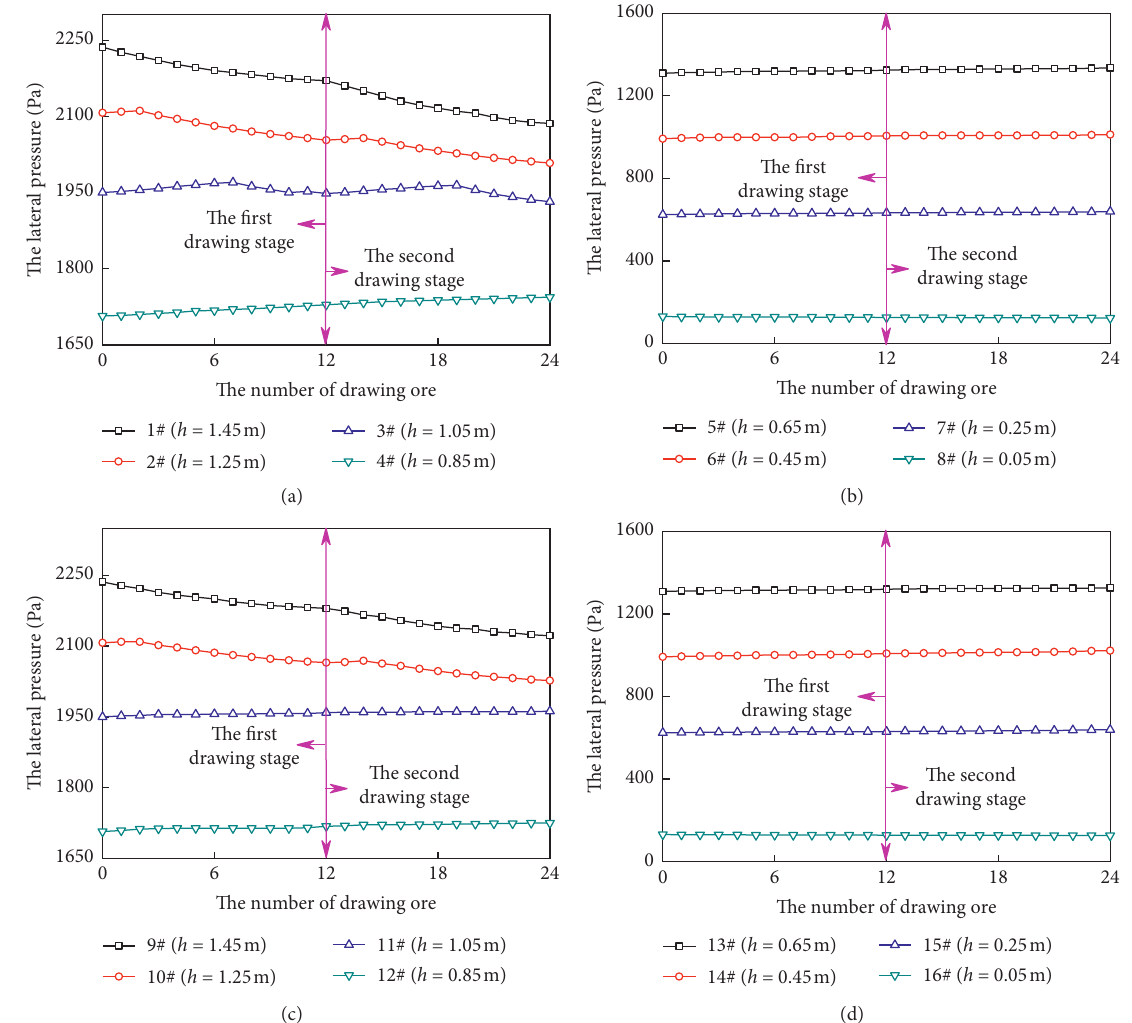
Figure 6: The relationship between the number of drawing ore and the values of lateral pressure with scheme